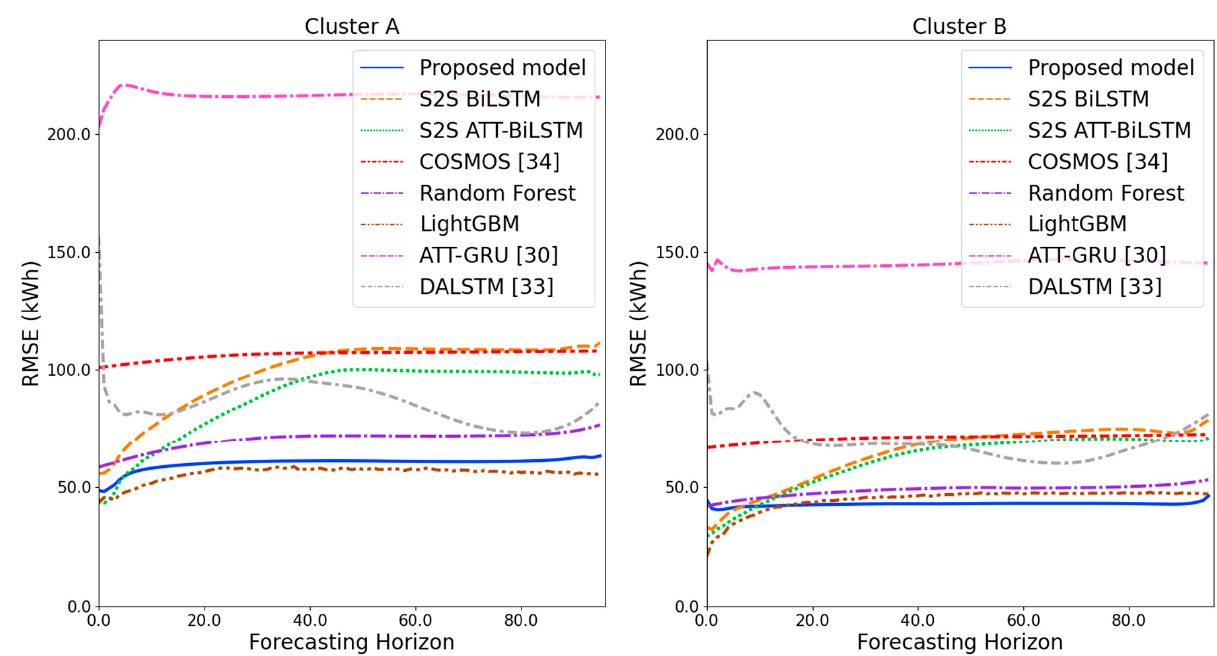
Figure 17. RMSE results of clusters A and B over the entire forecasting horizon (kWh).